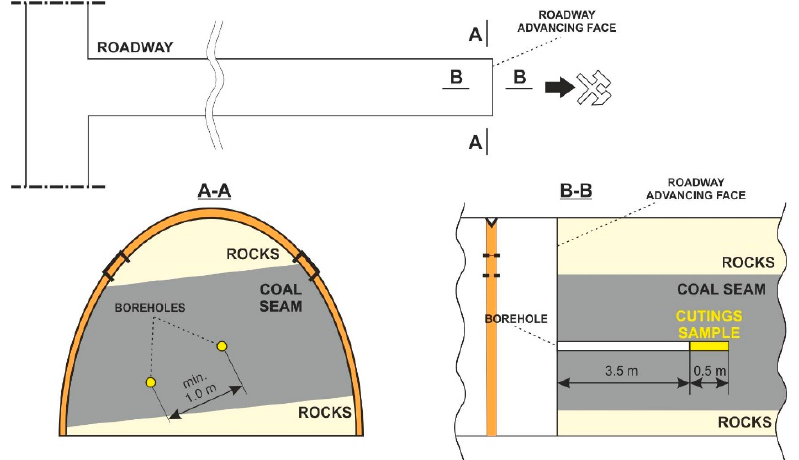
Figure 7. Example of boreholes localization for collecting samples in the roadway advancing face.